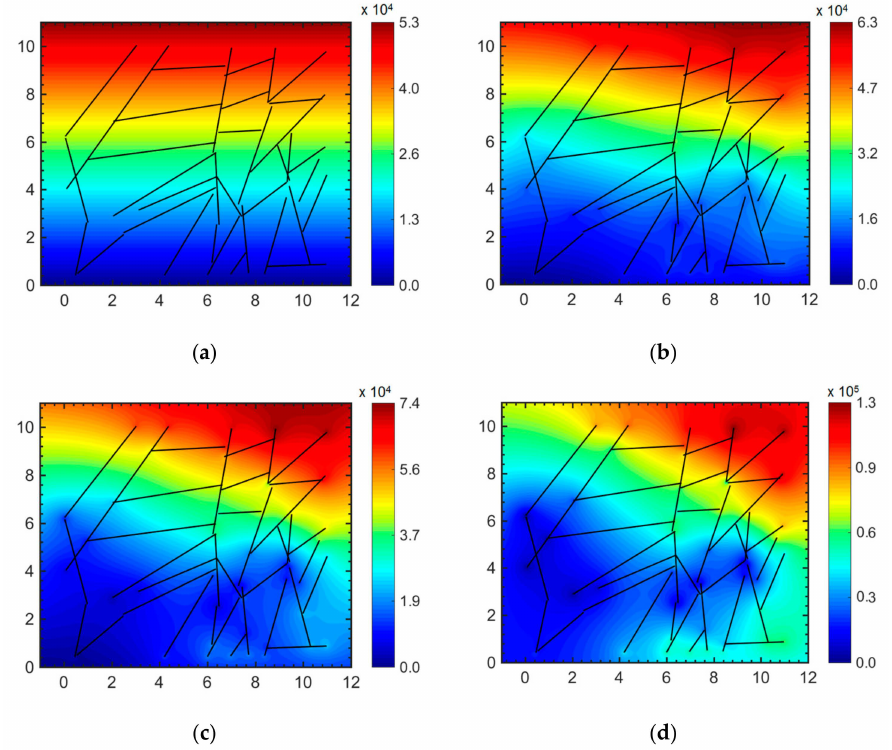
Figure 21. ( a – d ) Pressure fields (Case E) in Pascal corresponding to the stream function solutions given in Figure